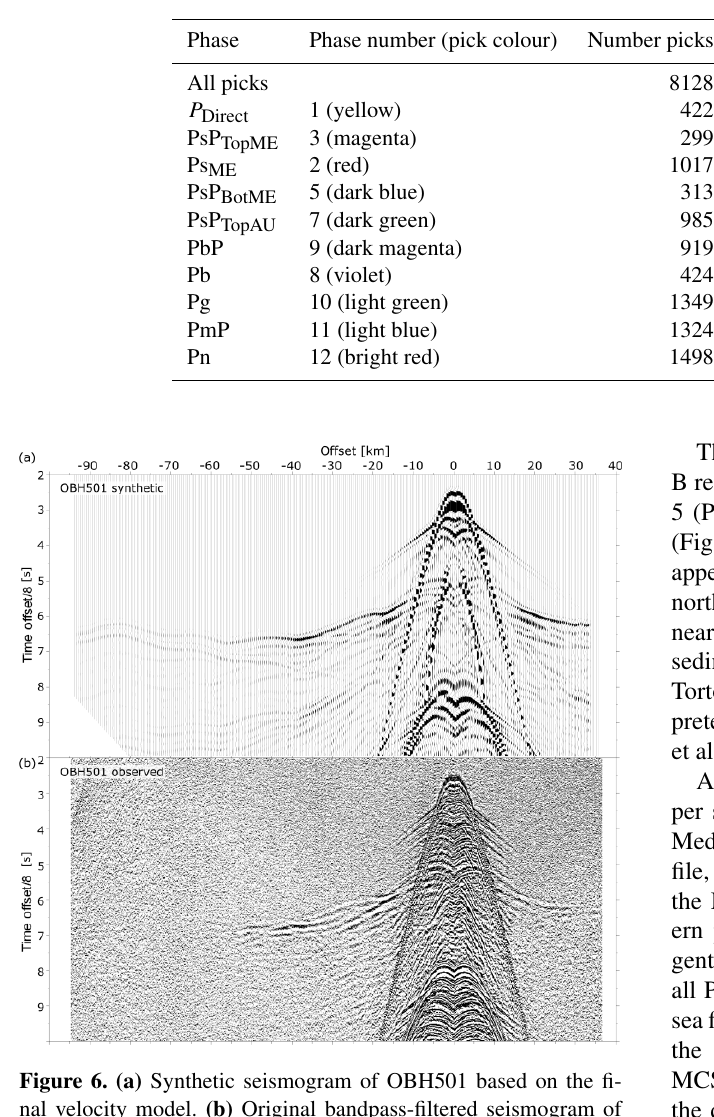
Table 1. Observed seismic phases with their pick number, number of picks, pick uncertainty, RMS fit, and Chi 2 to allow for an estimation of the robustness of the seismic velocity model obtained from forward modelling.